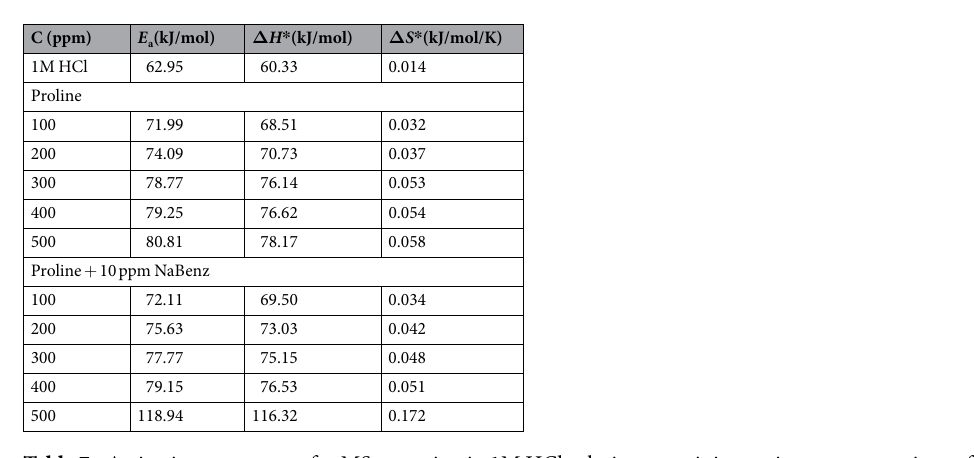
Table 7. Activation parameters for MS corrosion in 1M HCl solution containing various concentrations of LPr and LPr + 10 ppm